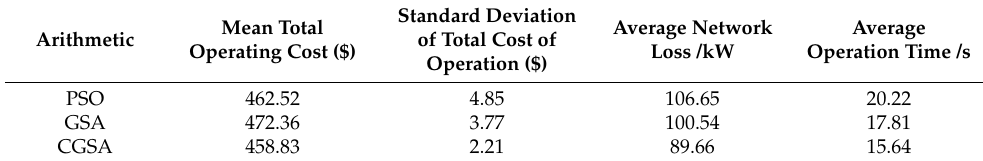
Table 2. The statistical results were calculated 20